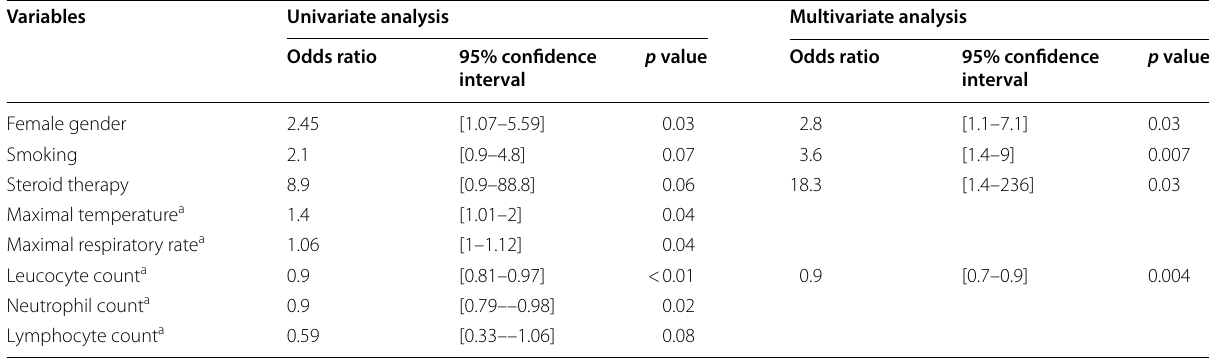
Table 4 Multivariate analysis of the risk factors for respiratory virus-associated infection in 123 HIV-infected patients admitted to the ICU for acute respiratory